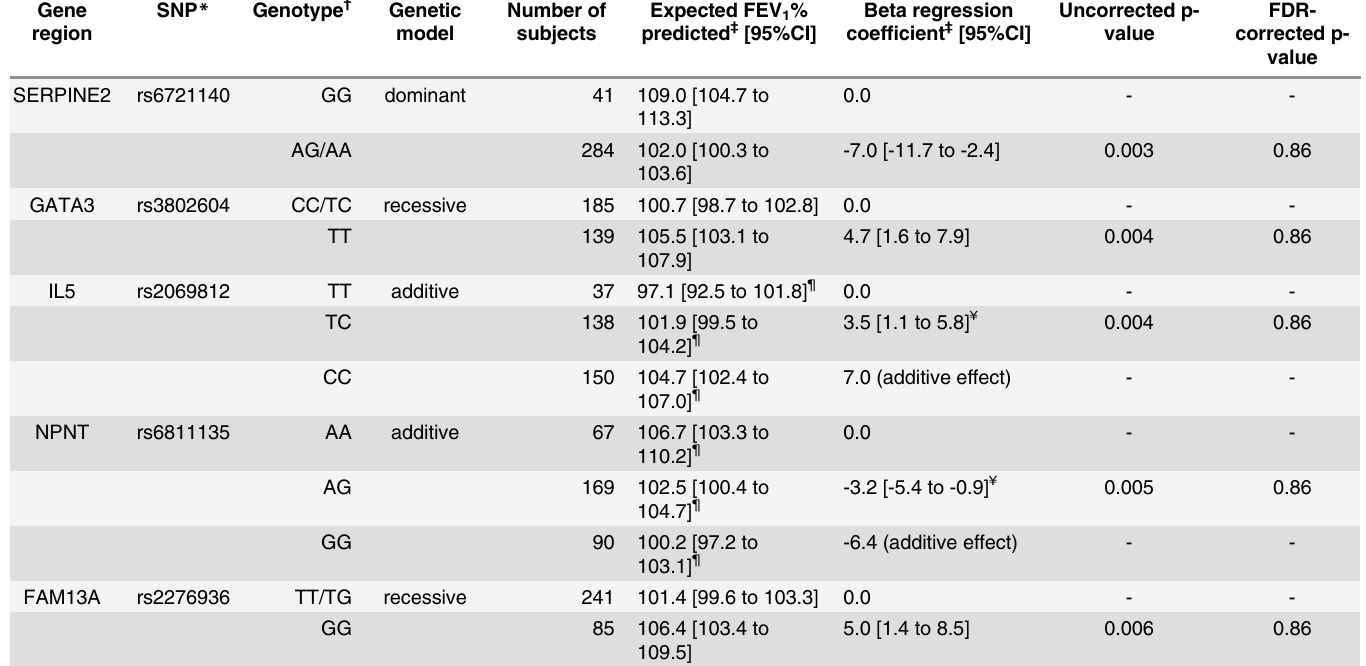
Table 4. Associations with lung